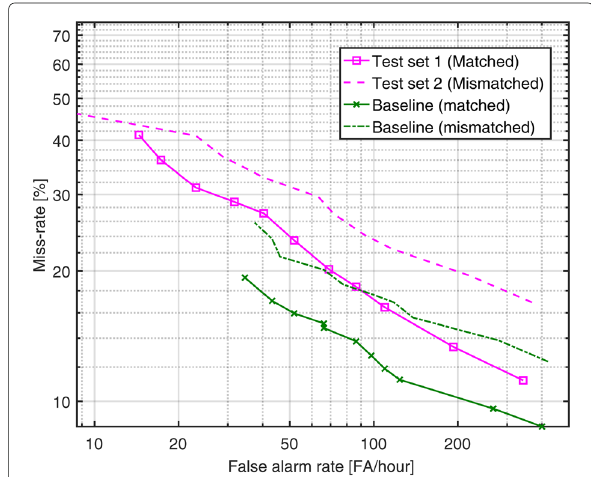
Fig. 10 Continuous audio stream test results showing the mean hit rate and false alarm rate in the range 0 − 20 dB SNR. Results are shown for the test network and the baseline network in matched and mismatched noise conditions. The test network was quantized to 8-bit activations and weights while the baseline network used floating-point precision